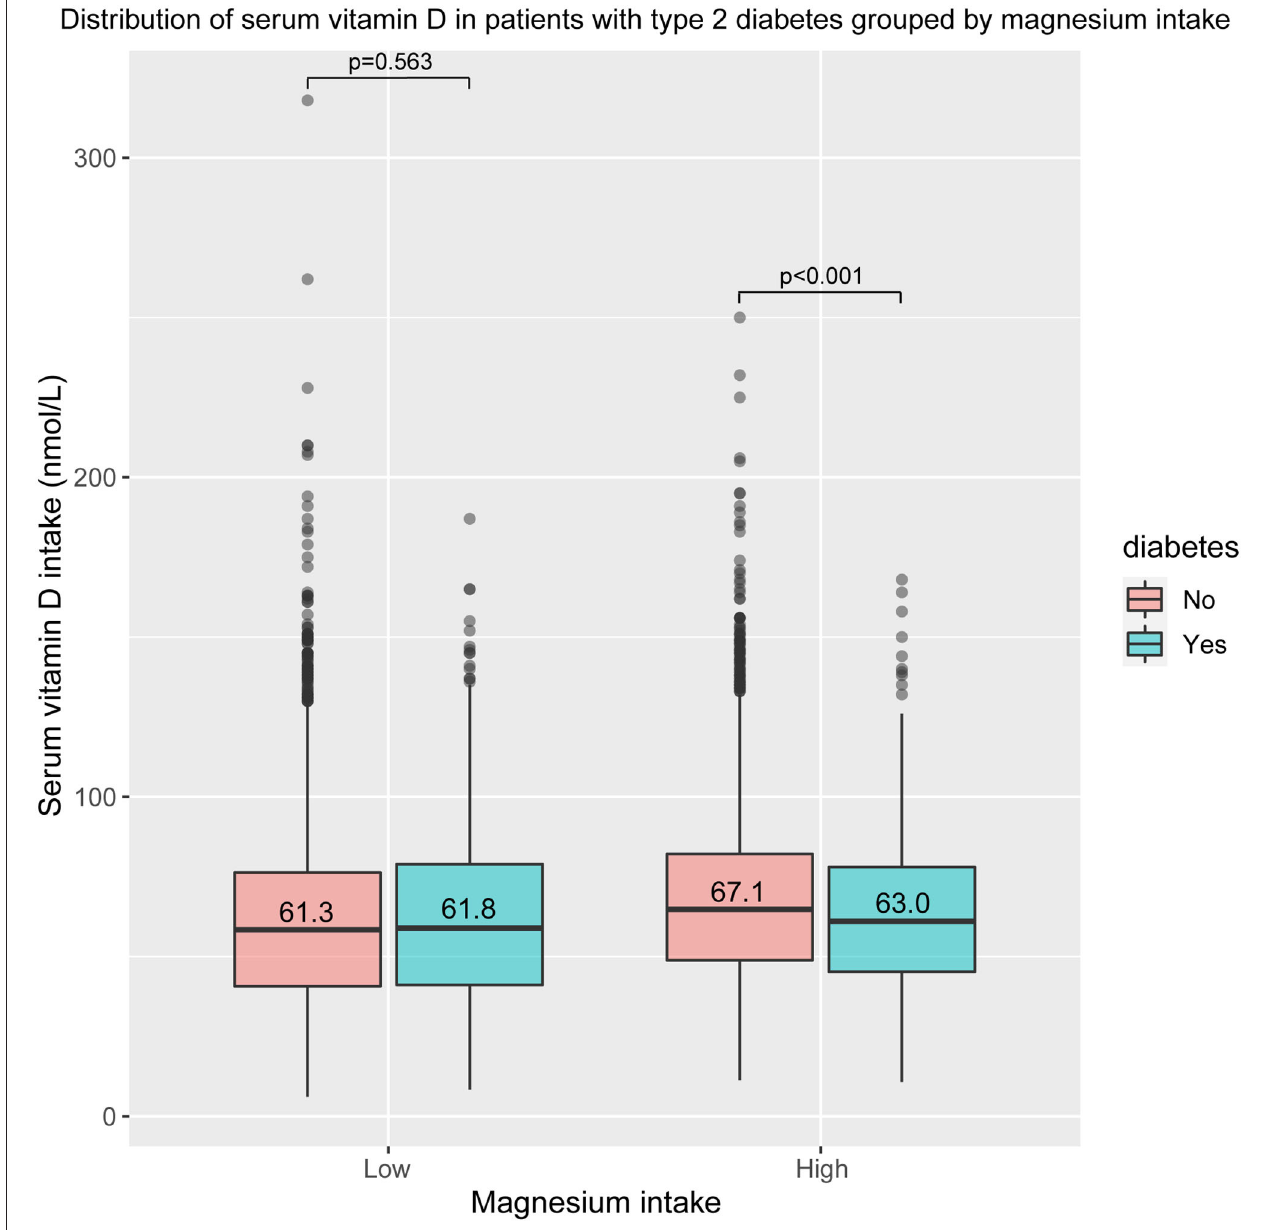
FIGURE 2 | Distribution of serum vitamin D in patients with type 2 diabetes (T2D) group by magnesium